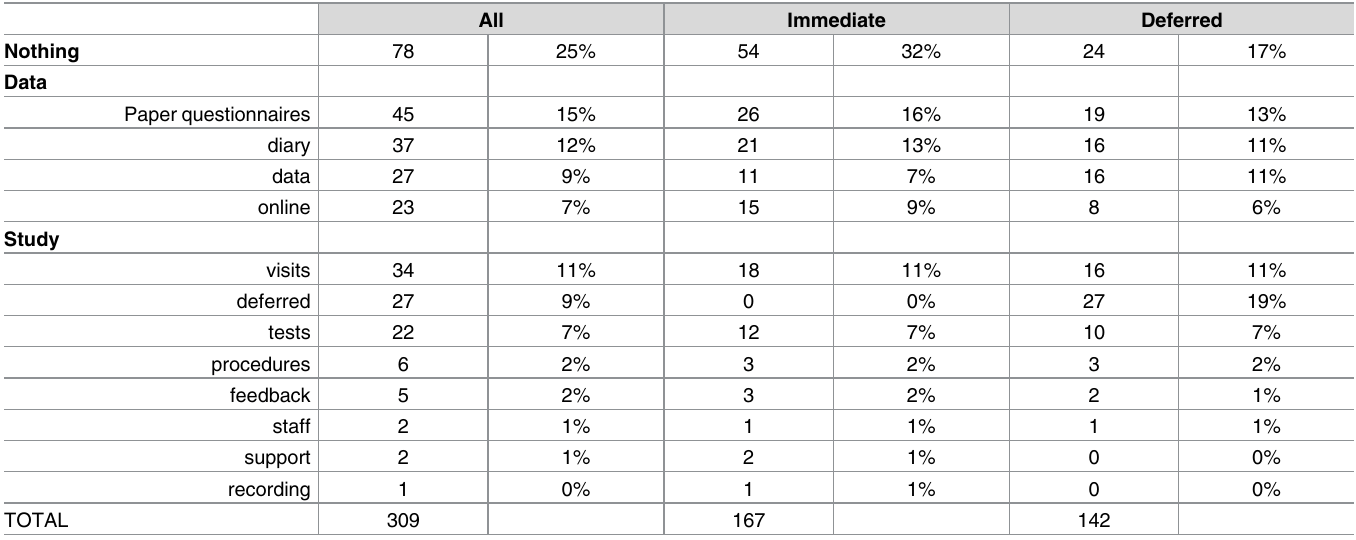
Table 3. What participants least liked about the